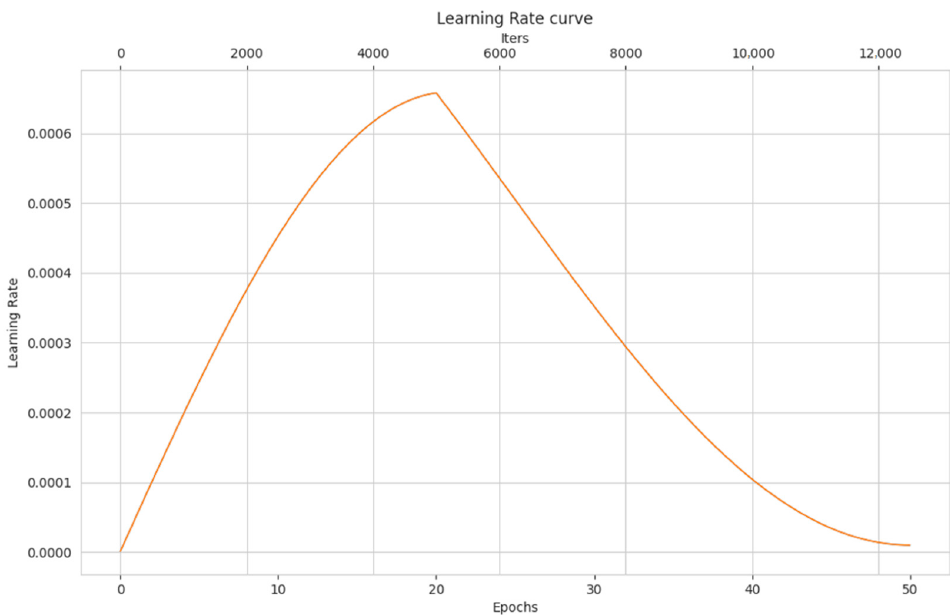
Figure 11. The learning rate change curve within 50 epochs.